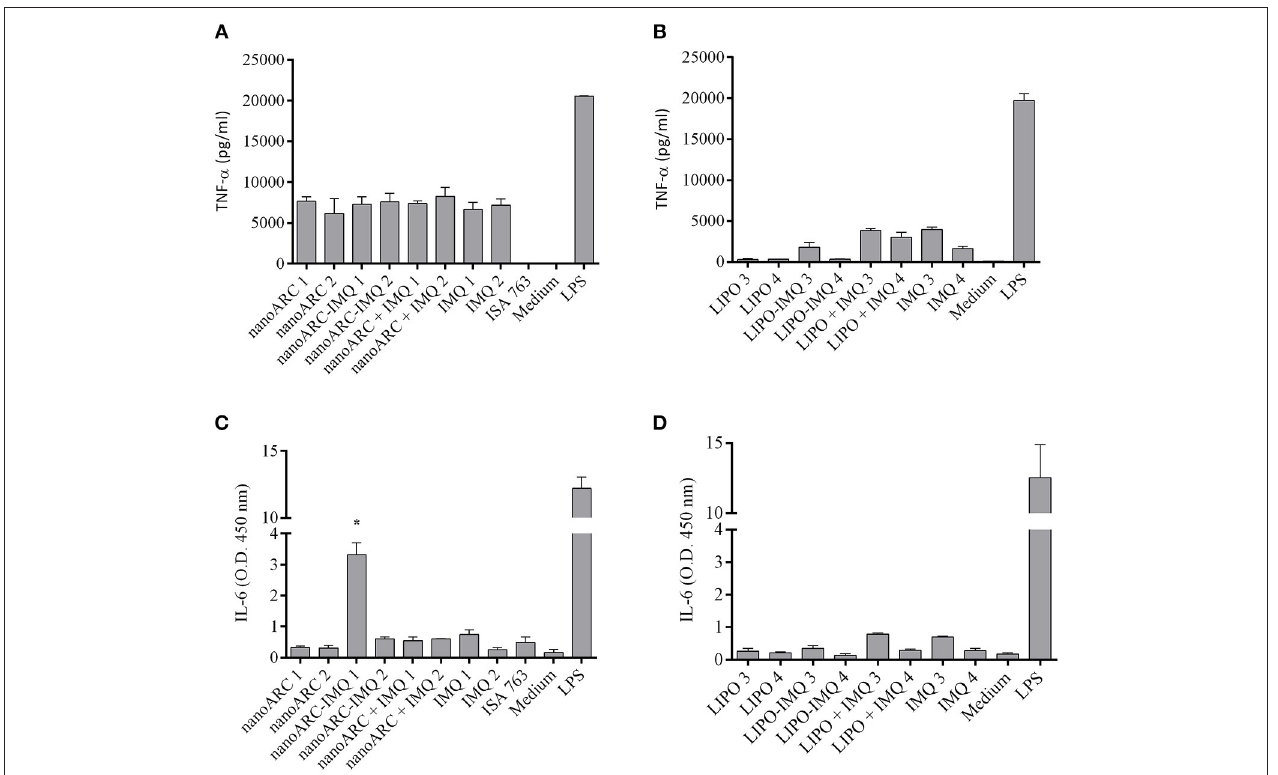
FIGURE 5 | Pro-inflammatory cytokines released by J774A.1 cells. (A,B) TNF- α and (C,D) IL-6 released upon 24h of incubation free IMQ, nanoARC-IMQ and remainder IMQ formulations. Values are expressed as mean ± SD ( n = 3 batches). Asterisks denotes significant differences against